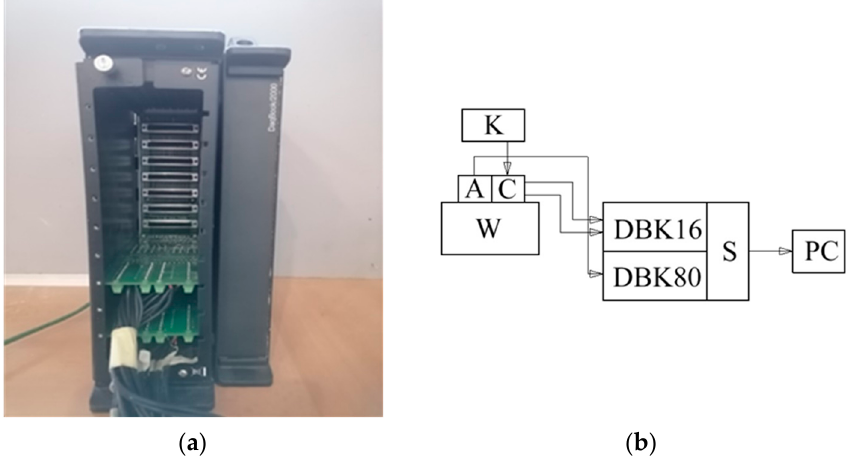
Figure 3. Compiled measuring system: ( a ) completed DaqBook 2001 measurement computing system equipped with expansion cards; ( b ) transducer test block diagram for harmonic excitations (K—FLUKE718 1G pressure calibrator; W—adjustable vibrating table; A—ADXL accelerometer; C—tested transducer; S—DaqBook 2001 measurement system + DBK41 expansion module + DBK16 strain gage expansion card + DBK80 di ff erential voltage input card with excitation; PC—computer with DasyLab 2020 software).